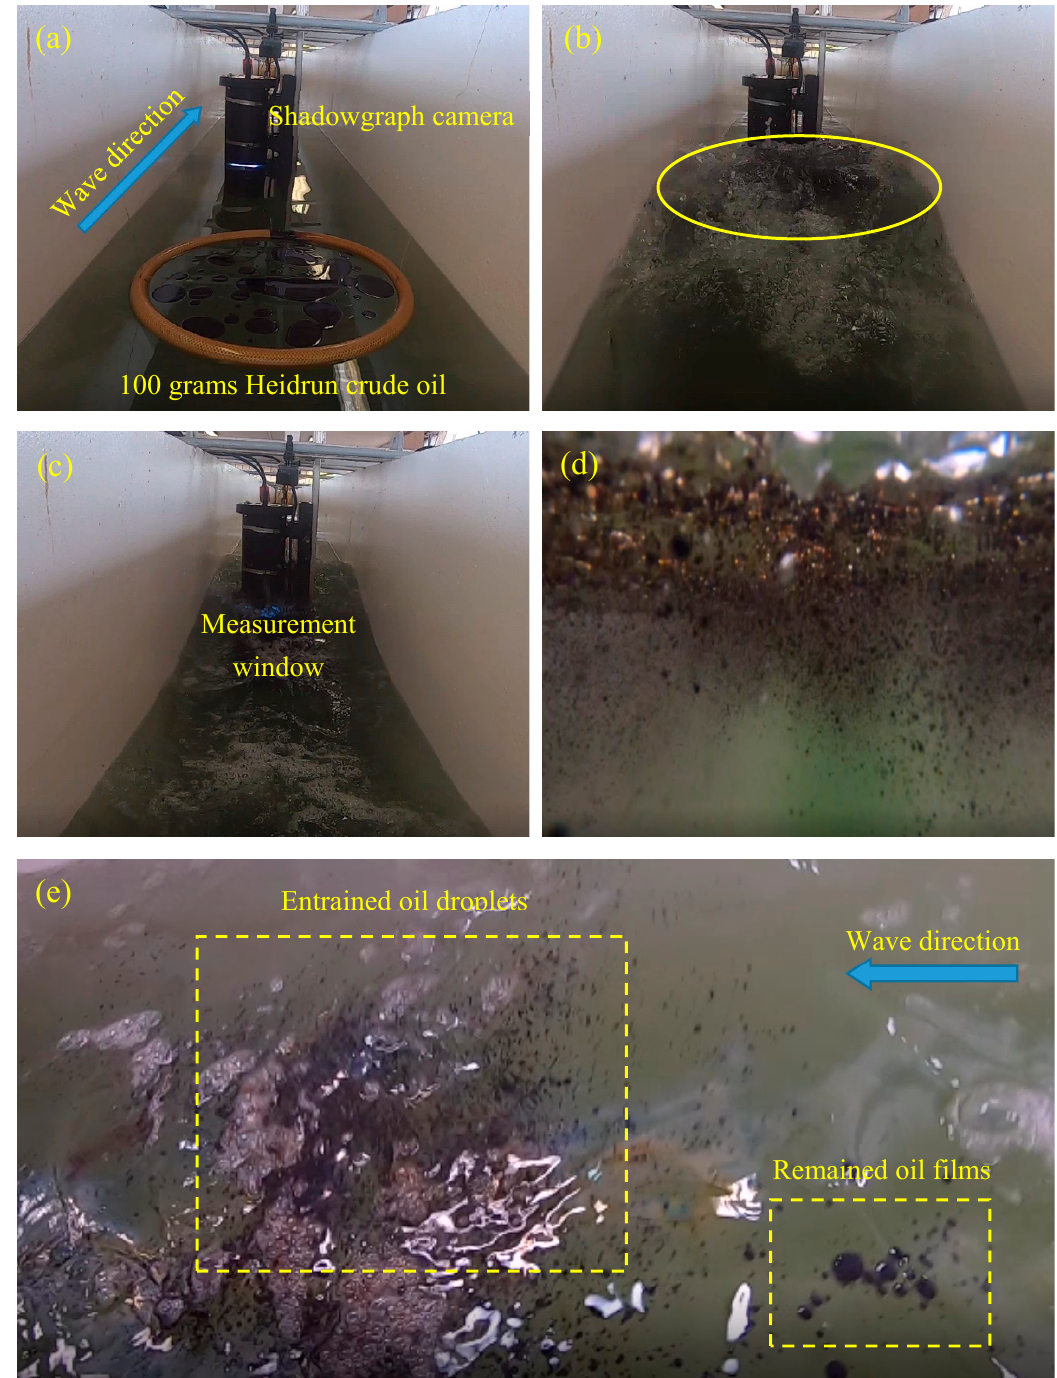
Figure 7. The snapshots of oil dispersion experiments: ( a ) the original setup; ( b ) the plunging breaker hitting the oil plume (within the yellow circle); ( c ) the dispersed oil being transported to the measurement window of the shadowgraph camera; ( d ) underwater view of entrained oil droplets, and ( e ) side view of entrained oil droplets and remained oil films.